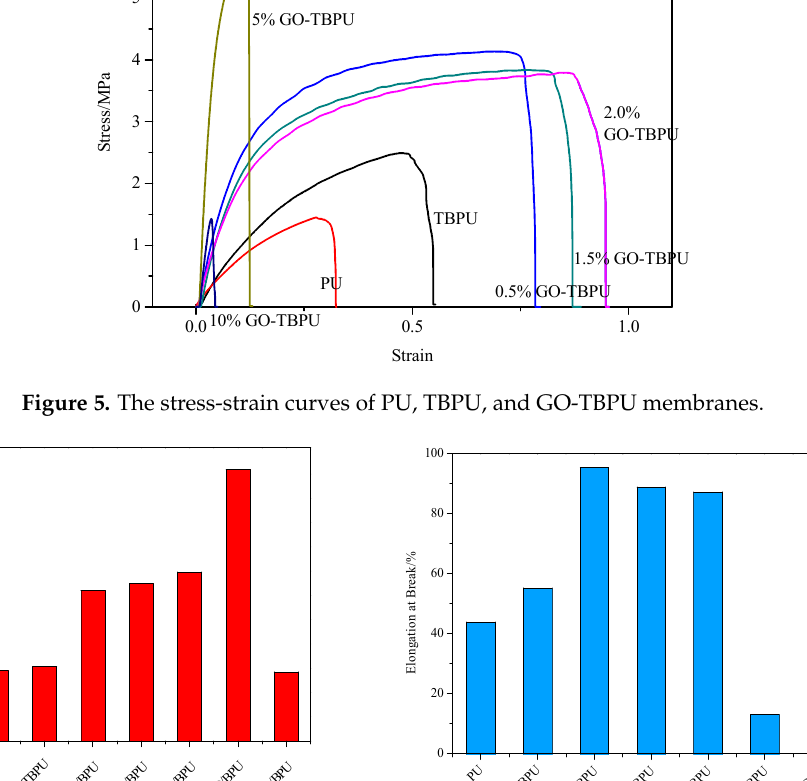
Figure 5. The stress-strain curves of PU, TBPU, and GO-TBPU membranes.